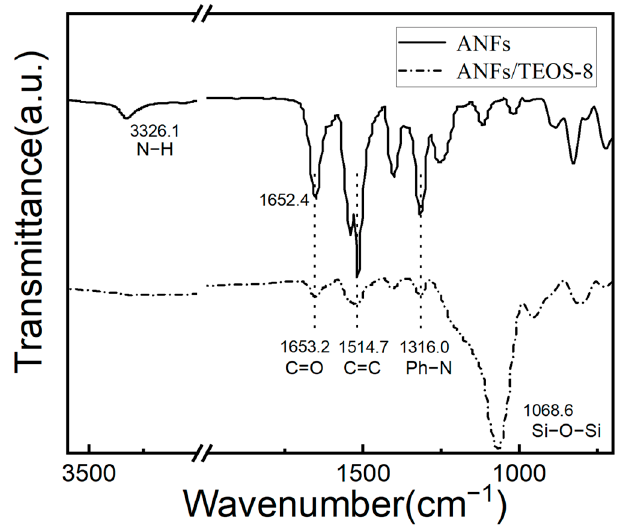
Figure 3. FTIR spectra of the ANFs aerogel and the aramid fibers@silica aerogel obtained by CVD 8 h with main peaks assignment.